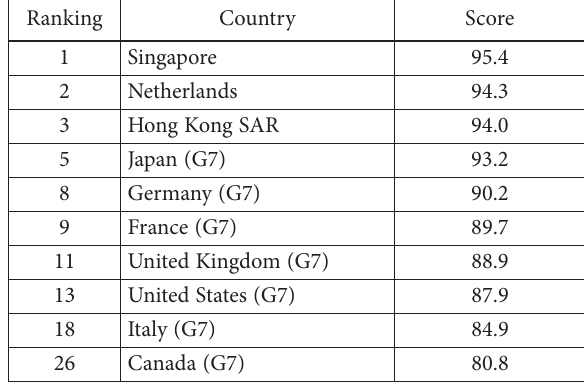
Table 3. Ranking of countries by quality of infrastructure